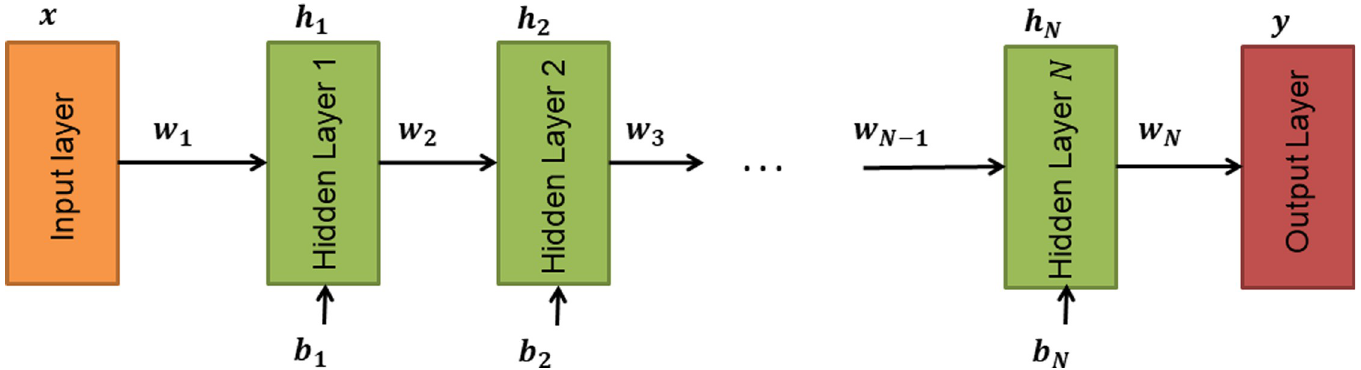
Fig 2. FNN design architecture.